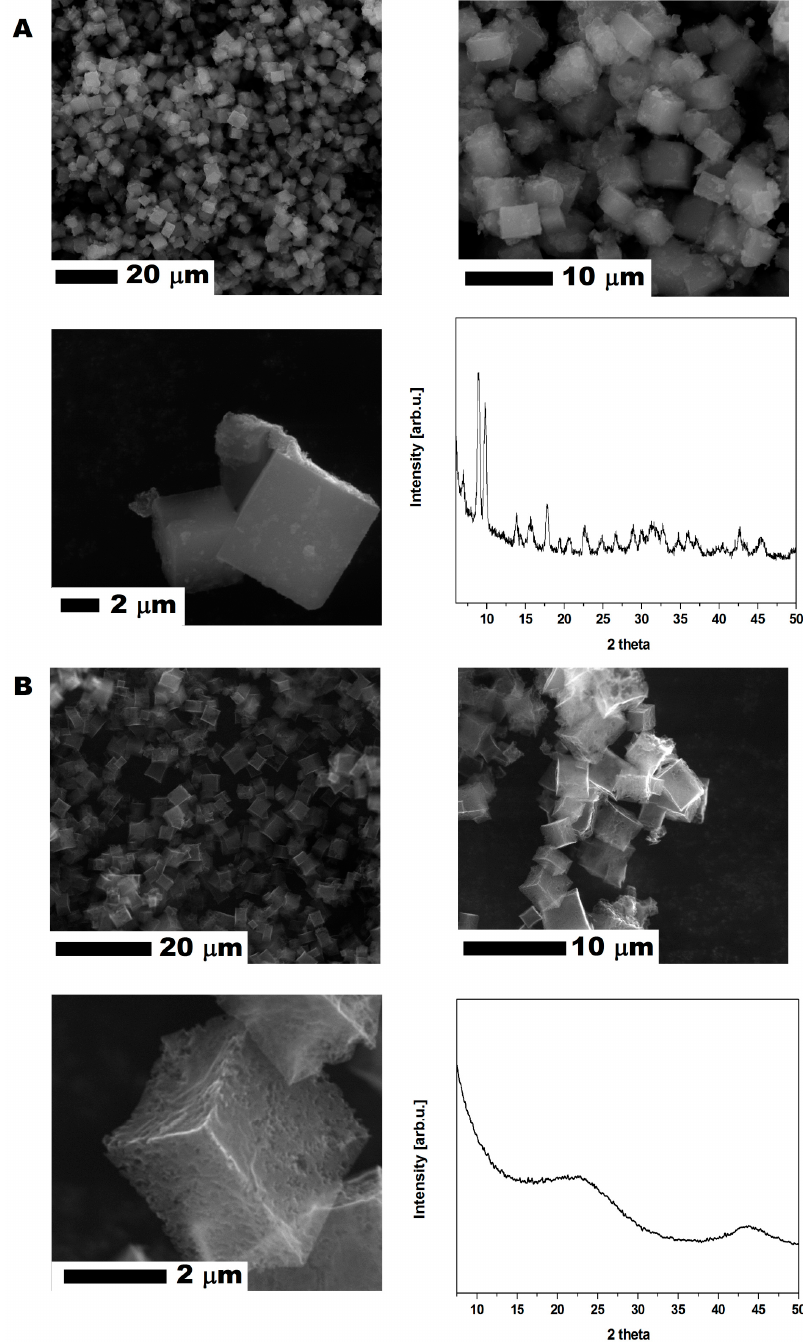
Figure 1. The SEM images of MOF-5 before ( A ) and after ( B ) carbonization with X-ray diffraction patterns.